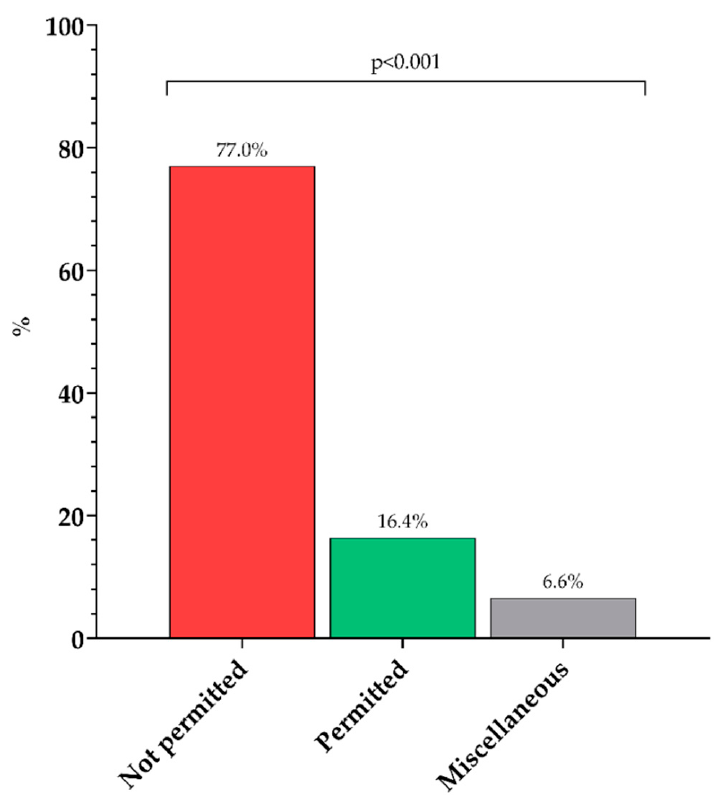
Figure 1. Frequency of food and beverage cues categorised according to the WHO Nutrient Profiling Model. Note: Significant differences were calculated using chi-squared